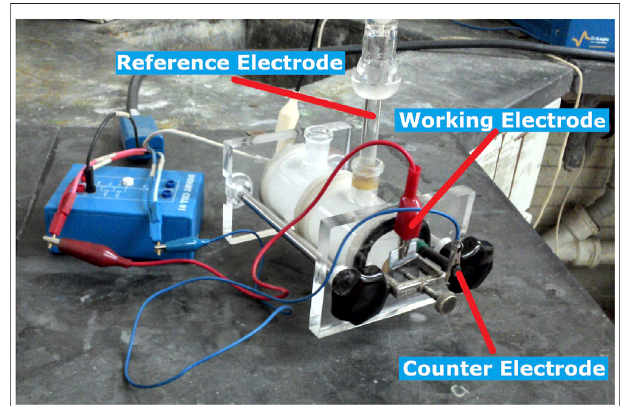
FIGURE 1 | Three-electrode electrochemical cell of acrylic and glass of about 10 cm × 15 cm, with a zinc plate as the working electrode, a saturated calomel electrode (SCE) as the reference electrode, and a graphite bar as the counter